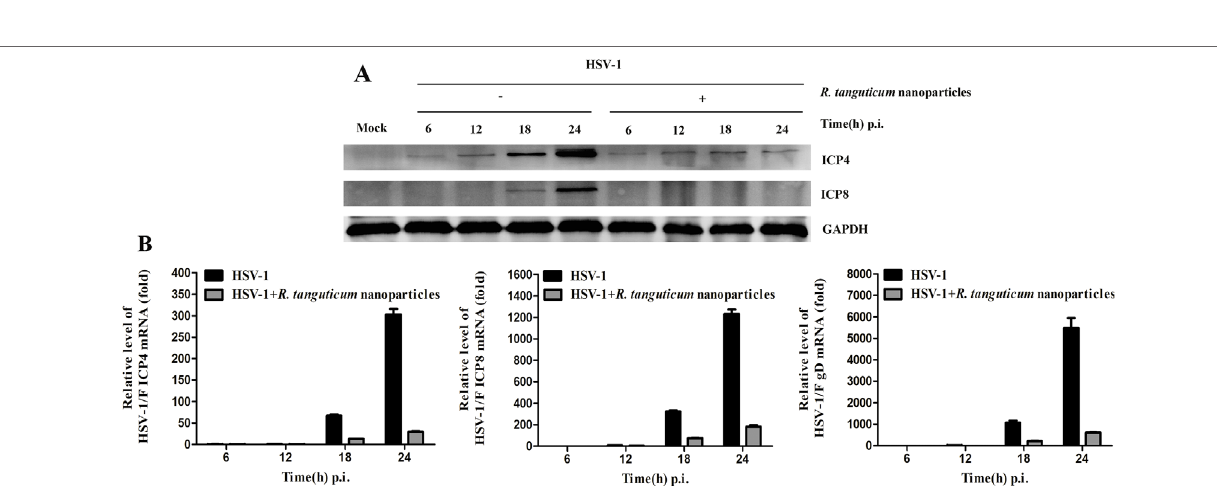
FIGURE 5 | The effect of R. tanguticum nanoparticles on HSV-1 immediate-early and early genes expression. (A) Western blot analysis: HEp-2 cells were infected with HSV-1 at an MOI of 0.01 and then treated with or without 350 µg/ml R. tanguticum nanoparticles. The cells were harvested at each time point (6, 12, 18, and 24 h) for western blot analysis of ICP4 and ICP8 . (B) Real-time quantitative PCR analysis: HSV-1 (MOI = 0.01) infected cells were treated with 350 µg/ml R. tanguticum nanoparticles for 6, 12, 18, and 24 h.p.i. post-infection. Total RNA was extracted and subjected to cDNA synthesis. The real-time quantitative PCR was performed ICP4 -, ICP8 -, and gD -specific primers. Values are represented as the mean ± standard deviation of three individual